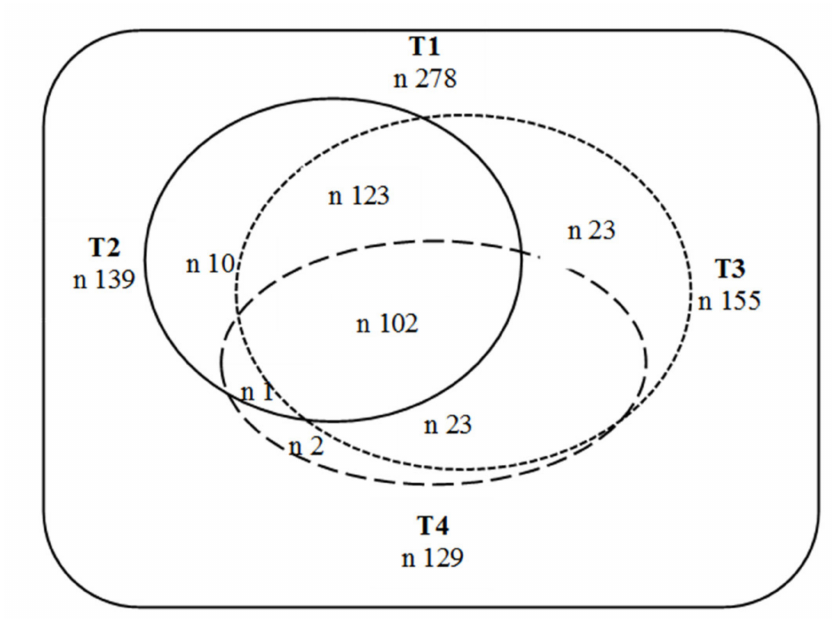
Figure 1. Sample composition at each time point of the longitudinal